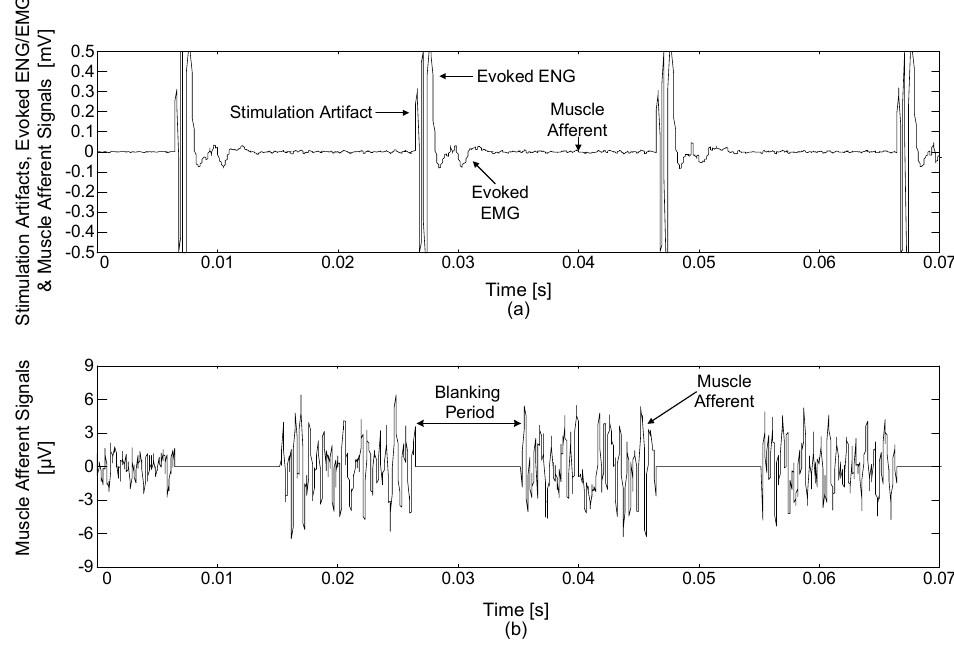
Figure 19. Acquired neural signals: ( a ) when the blanking processes were not applied and ( b ) when the blanking processes were applied.